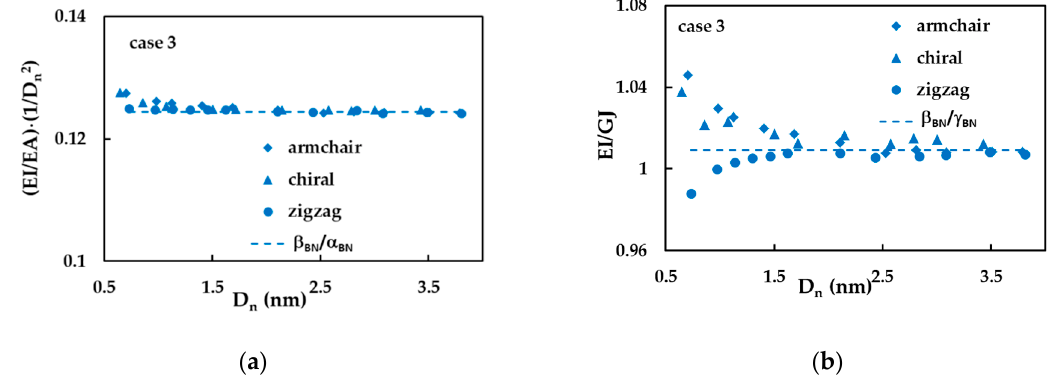
Figure 7. The evolutions of the ratios ( a ) (EI/EA) ⋅ (1/D n3 ) and ( b ) EI/GJ with the nanotube diameter, D n , for case 3.